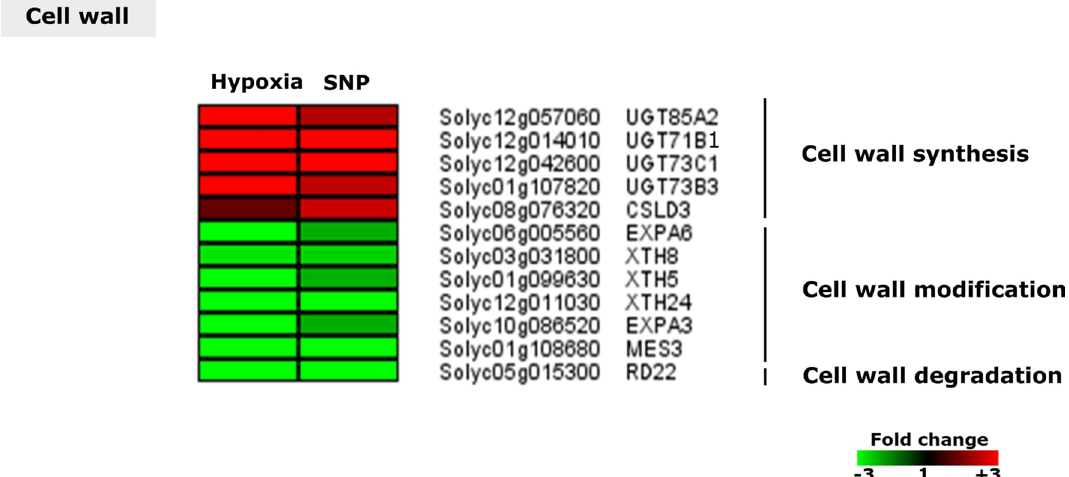
Figure 11. Expression pattern of regulated cell wall related genes. Heat map represents the up-regulated (red bars) or down-regulated (green bars) tomato genes and their Arabidopsis thaliana homologs in response to hypoxia and SNP-treatment. Depicted are differentially expressed genes ( Padj < 0.05), ( n = 3). UGT85A2 , UDP-GLUCOSYL TRANSFERASE 85A2 ; UGT71B1 , UDP-GLUCOSYL TRANSFERASE 71B1 ; UGT73C1 , UDP-GLUCOSYL TRANSFERASE 73C1 ; UGT73B3 , UDP-GLUCOSYL TRANSFERASE 73B3 ; CSLD3 , CELLULOSE SYNTHASE LIKE D3 ; RD22 , RESPONSIVE TO DESICCATION 22 ; EXPA6 , EXPANSIN 6 ; XTH8 , XYLOGLUCAN ENDOTRANSGLUCOSYLASE/HYDROLASE 8 ; XTH5 , XYLOGLUCAN ENDOTRANSGLUCOSYLASE/HYDROLASE 5 ; XTH24 , XYLOGLUCAN ENDOTRANSGLUCOSYLASE/ HYDROLASE 24 ; EXPA3 , EXPANSIN 3 ; MES3 , METHYL ESTERASE 3